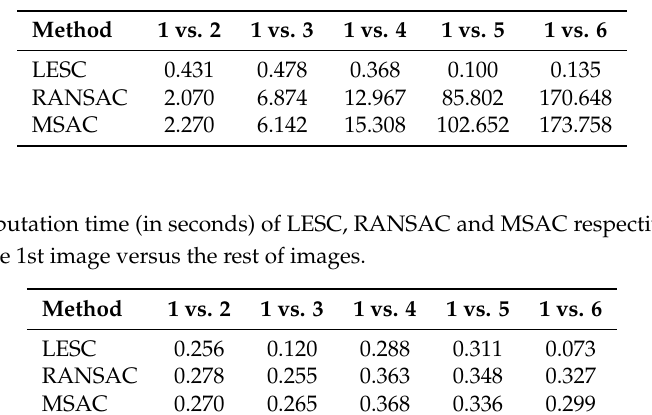
Table 4. The computation time (in seconds) of LESC, RANSAC and MSAC respectively on the Boat sequence using the 1st image versus the rest of images.